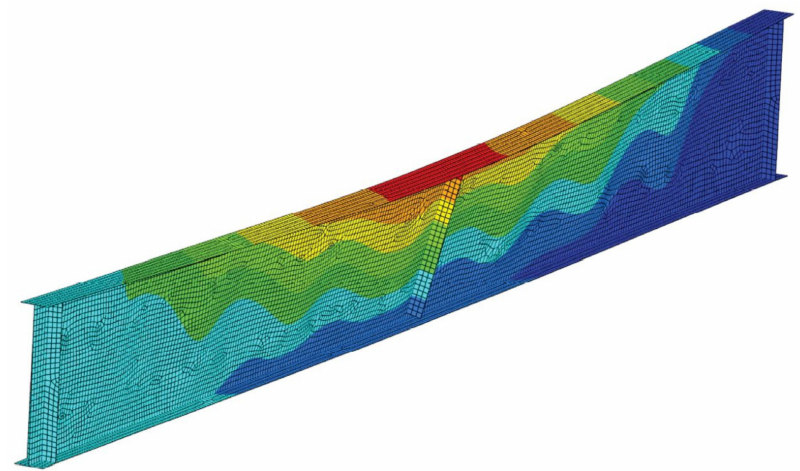
Figure 19. Failure mode—beam B2, scale × 1.